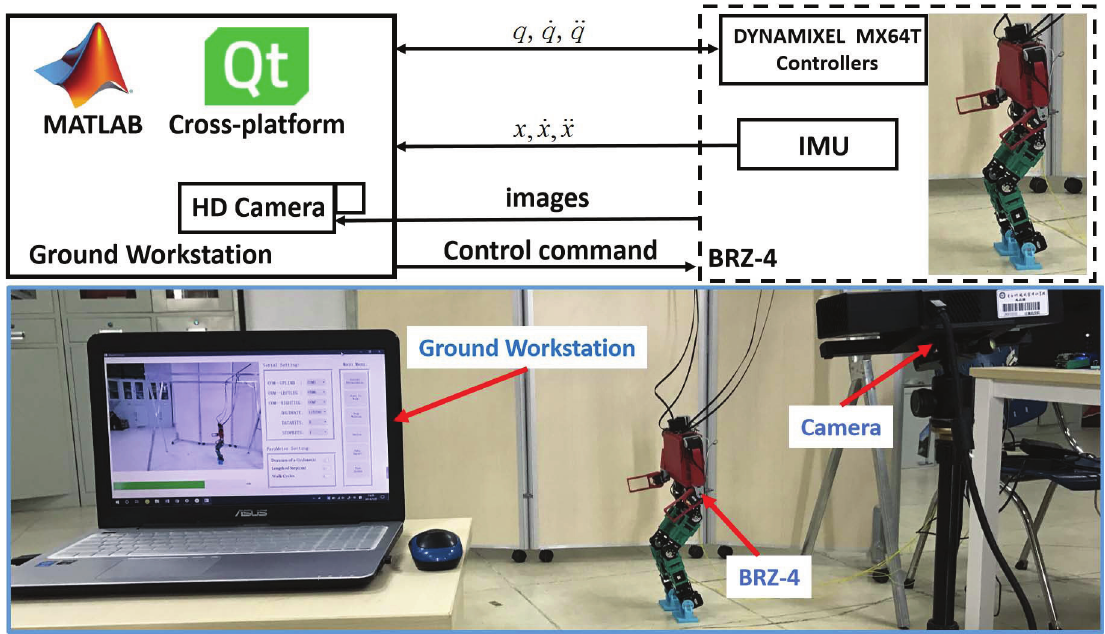
Figure 4. Basic components of hardware